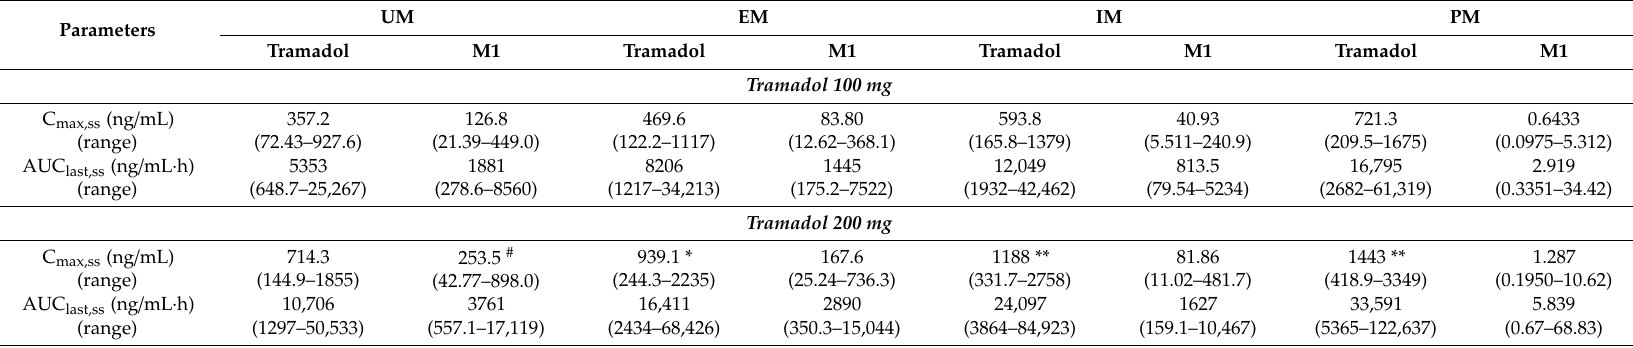
Table 6. Predicted geometric mean C max,ss and AUC last,ss values for tramadol and O -desmethyltramadol (M1) following oral administration of 100 and 200 mg